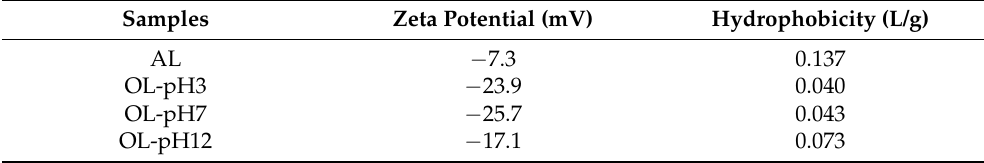
Table 5. The physicochemical properties of untreated and ozone pretreated alkali lignin. Samples Zeta Potential (mV) Hydrophobicity (L/g) AL − 7.3 0.137 OL-pH3 − 23.9 0.040 OL-pH7 − 25.7 0.043 OL-pH12 − 17.1